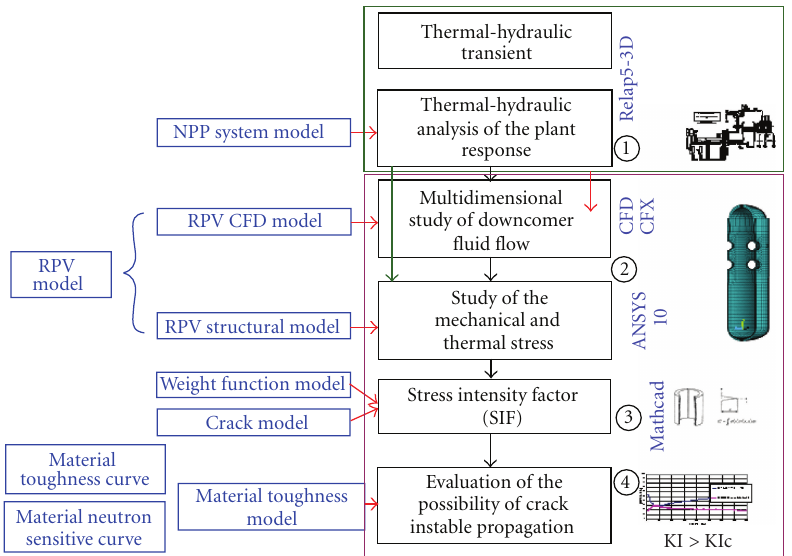
Figure 1: UNIPI methodology for PTS